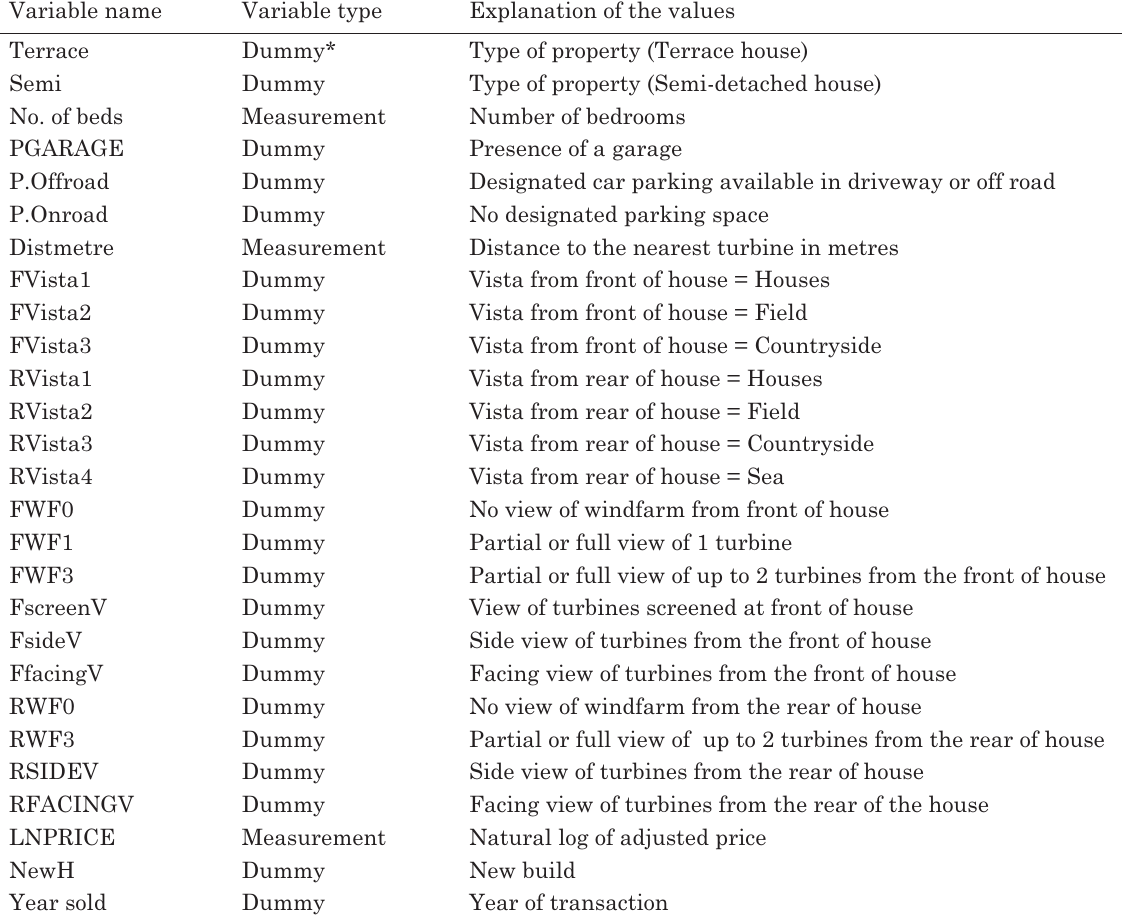
Table 1. Variables used in the